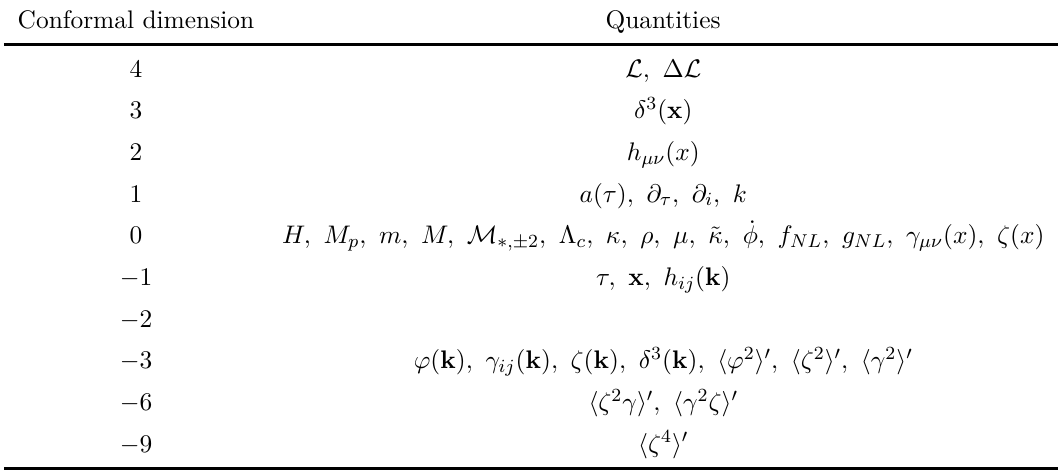
Table 2 . A list of the conformal dimensions of various quantities. Open